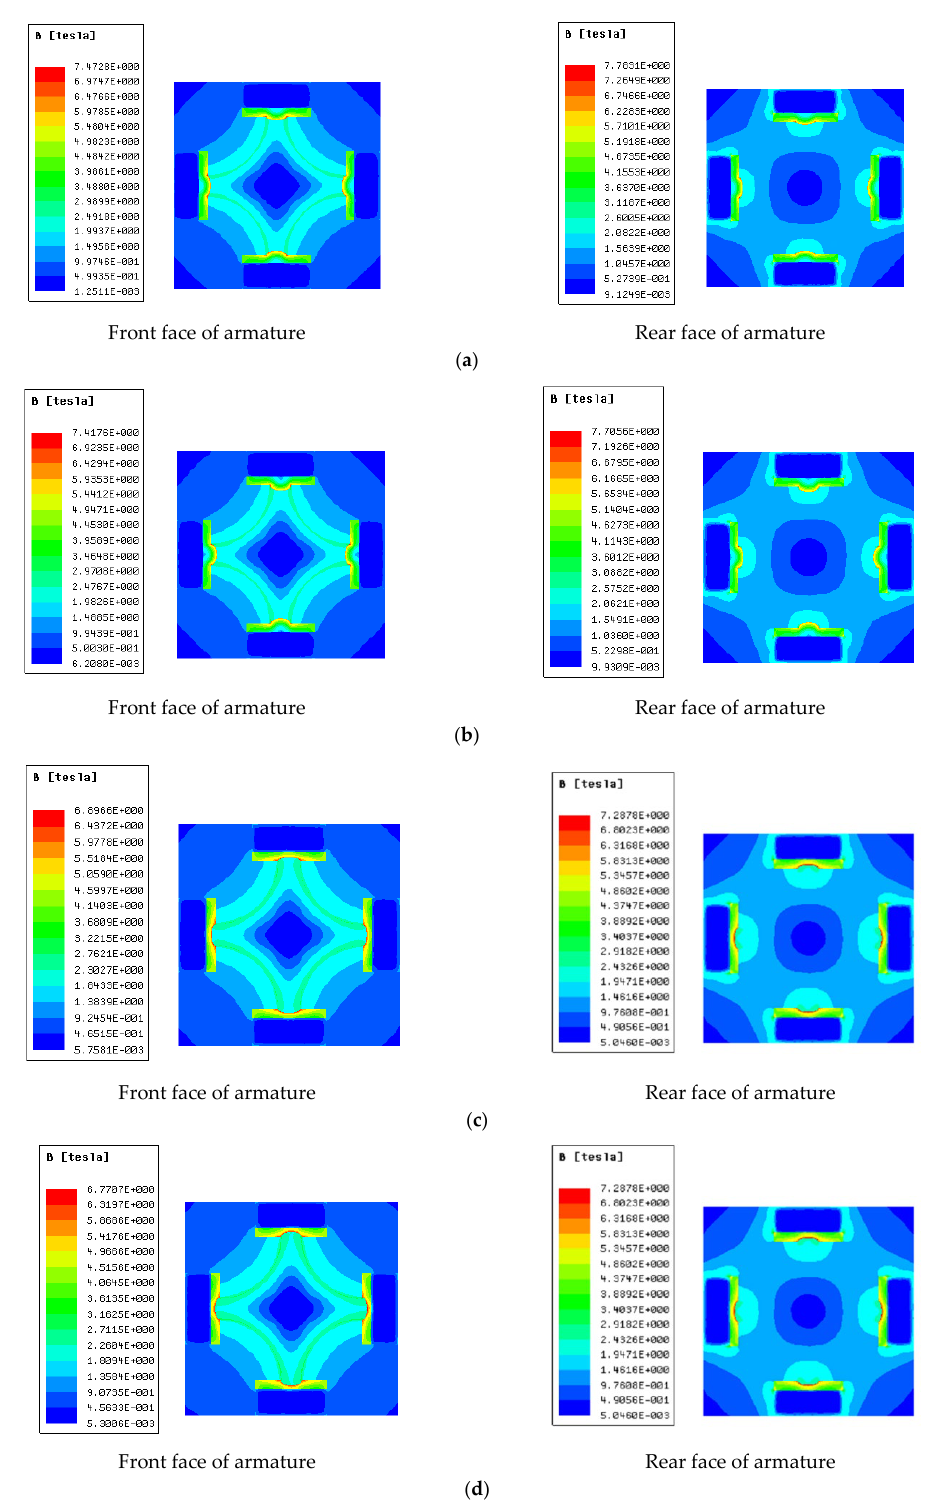
Figure 8. Magnetic field distribution on the end face of armature with different concave (convex) values: ( a ) concave oval armature (a = 2 mm); ( b ) concave oval armature (a = 3 mm); ( c ) convex oval armature (a = 2 mm); ( d ) Convex oval armature(a = 3 mm).